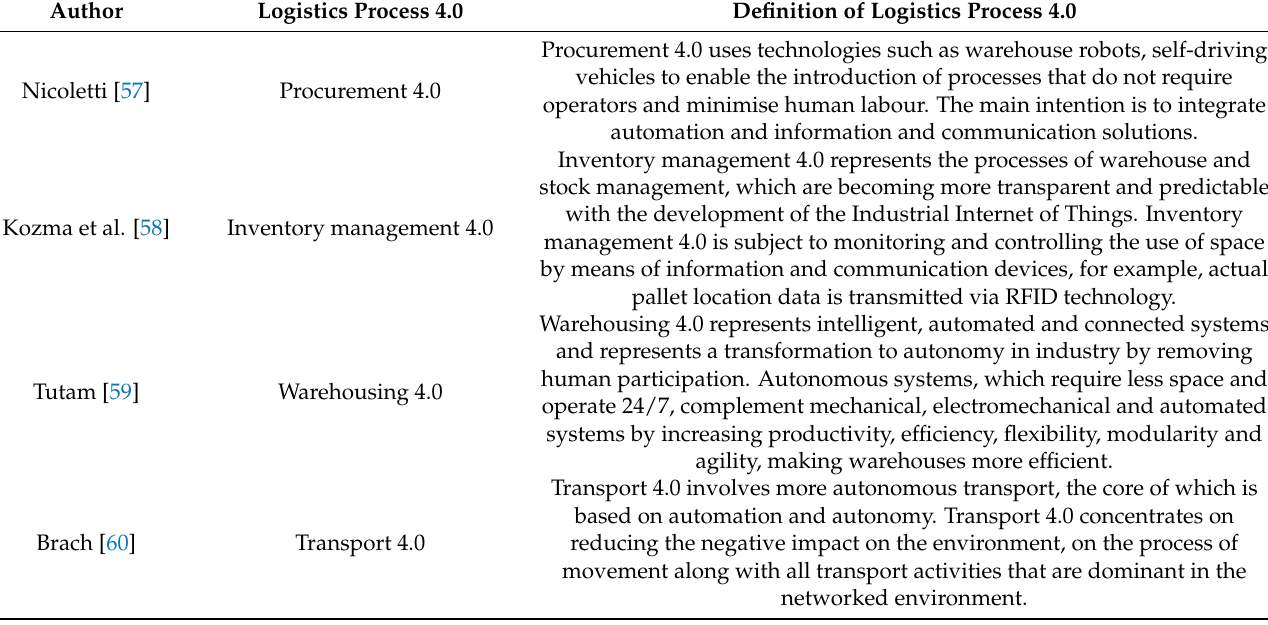
Table 1. Definition of logistics process